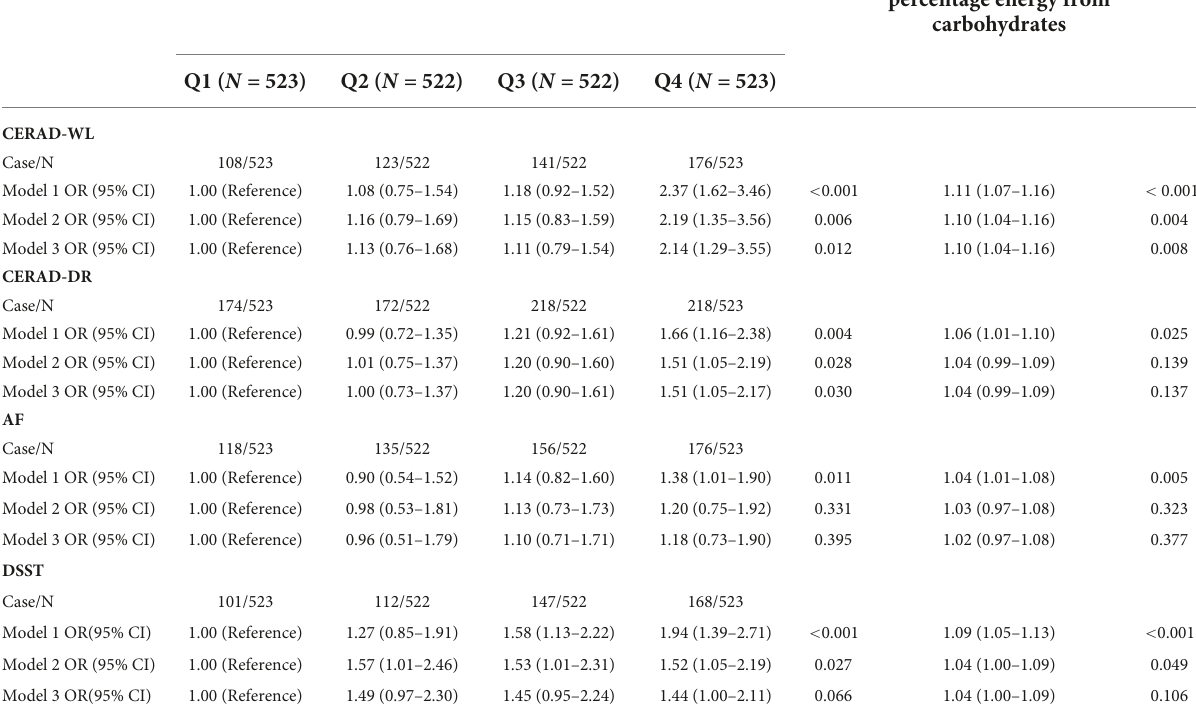
TABLE 2 Association of dietary carbohydrates with poor cognitive performance among participants whose daily fasting duration was fewer than 16 h. Cognitive test